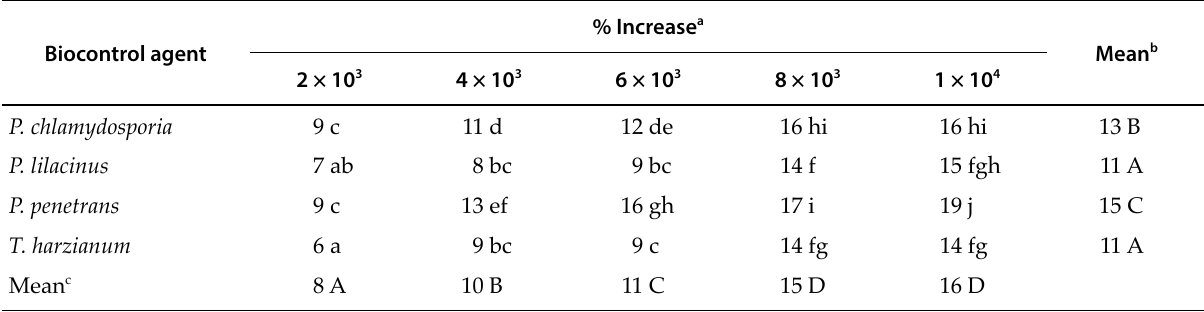
Table 1. Mean proportional increases in shoot fresh weights of okra plants after treatments with different nematode bio - control agents applied at different propagule concentrations.